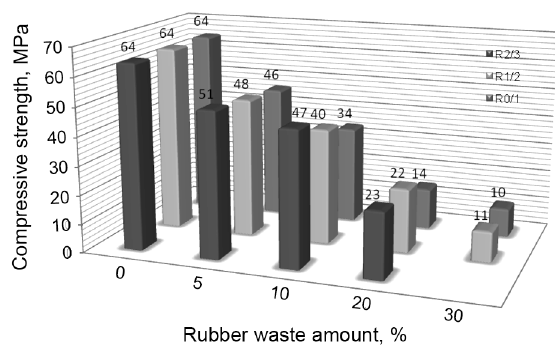
Fig. 2. The change in the compressive strength of concrete with CR of different amount and size fraction